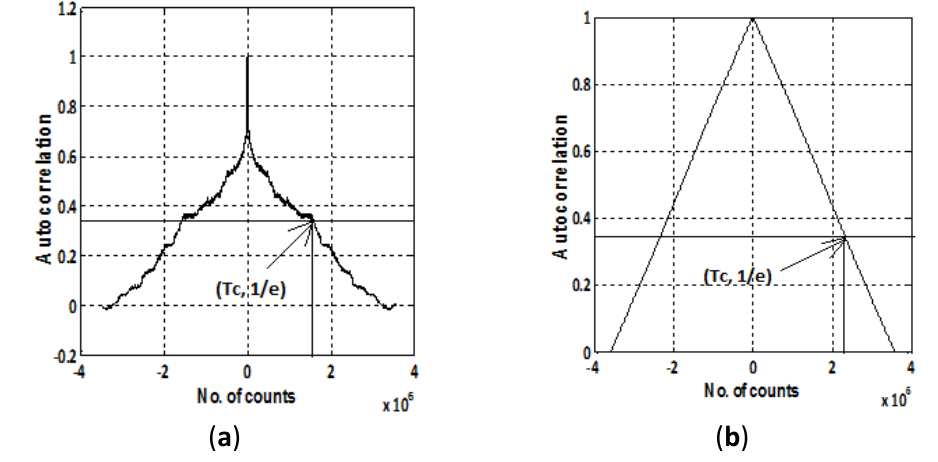
Figure 6. Autocorrelation sequence: ( a ) gyroscope; ( b ) accelerometer.